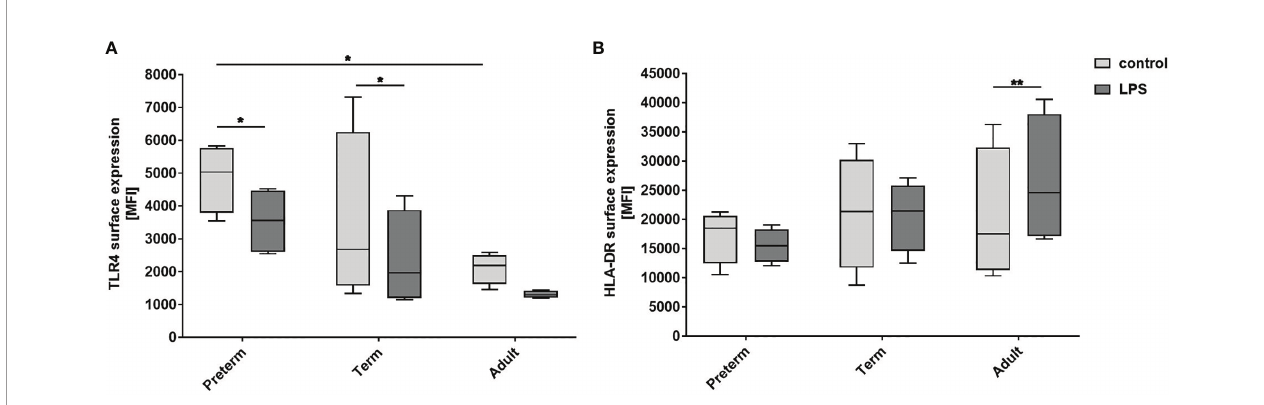
FIGURE 3 | Expression of activation markers on preterm, term, and adult macrophages (M Ф ) after LPS stimulation. LPS-stimulated M Ф of preterm infants compared to term and adult M Ф incubated for 72 h (48 h 21% O 2 followed by 24 h at 21% O 2 with or without LPS). (A) Surface expression of TLR4. (B) Surface expression of HLA-DR. Mean fl uorescence intensity [MFI] of surface proteins on macrophages in all three groups assessed by fl ow cytometry. (n=4 independent experiments with cells of four different donors, box plots: median ± 25 th to 75 th percentiles and minimum to maximum, ANOVA followed by Holm-Sidak ’ s test, *p<0.05, and